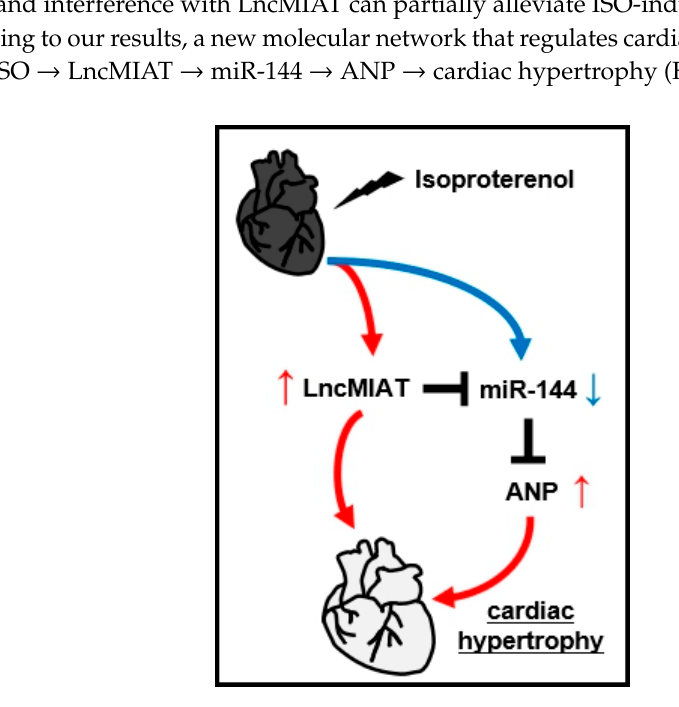
Figure S1: miRNAs and LncMIAT binding site. Table S1: Sequences of PCR primers used in this study, Table S2: KEGG analysis of target genes of di ff erentially-expressed miRNAs, Table S3: KEGG analysis of target genes of miR-144. Video S1: Isolated rat primary